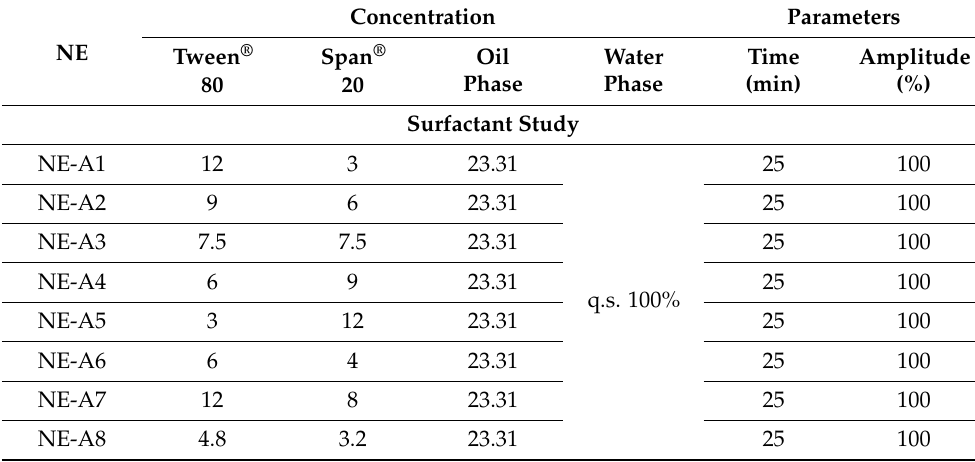
Table 2. Composition of the prepared NEs and variations in surfactant concentration (NE-A1 to NE-A8).